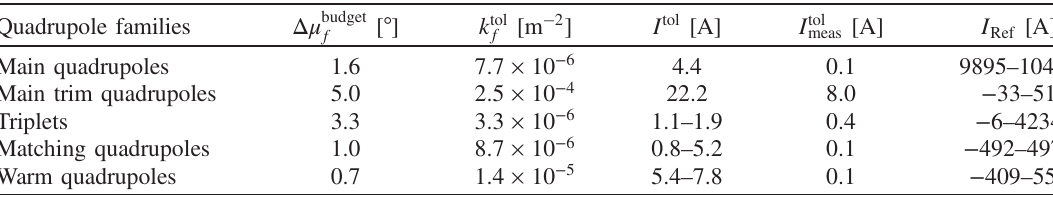
TABLE II. PcInterlock tolerances, k tol f and I tol , on quadrupole strength and currents operationally used in 2016 with β (cid:1) ¼ 40 cm and Δ μ budget ¼ 6 . 3 °. The limits obtained from current fluctuation measurement, I tol applied phase margin per family, Δ μ budget f , are given. Note that even though all magnets of one family have by definition the same tolerances on their strength k , they do not all have the same k -to- I transfer functions. Therefore, I tol